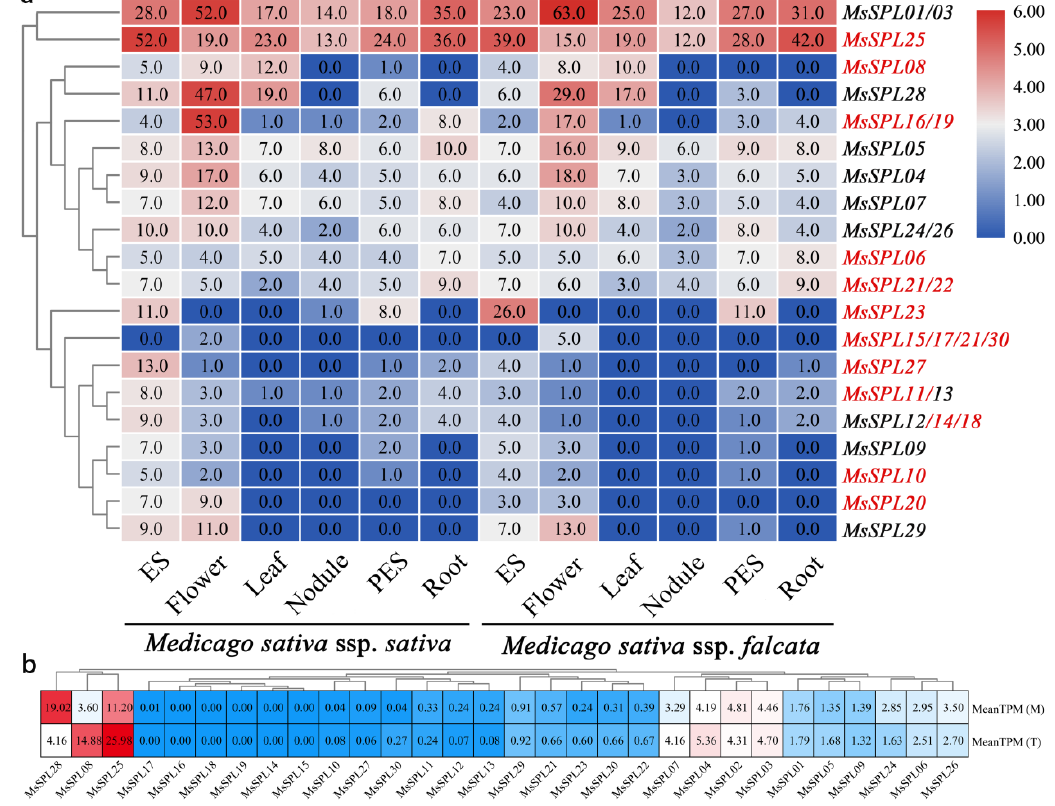
Figure 8. The expression pattern of MsSPL genes in various alfalfa tissues. ( a ) Heat map showing the expression change in PES (post-elongation stem internodes), flowers, leaf, nodule, ES (elongating stem internodes), and root. ( b ) The expression pattern of MsSPL genes between multifoliate and trifoliate alfalfa.